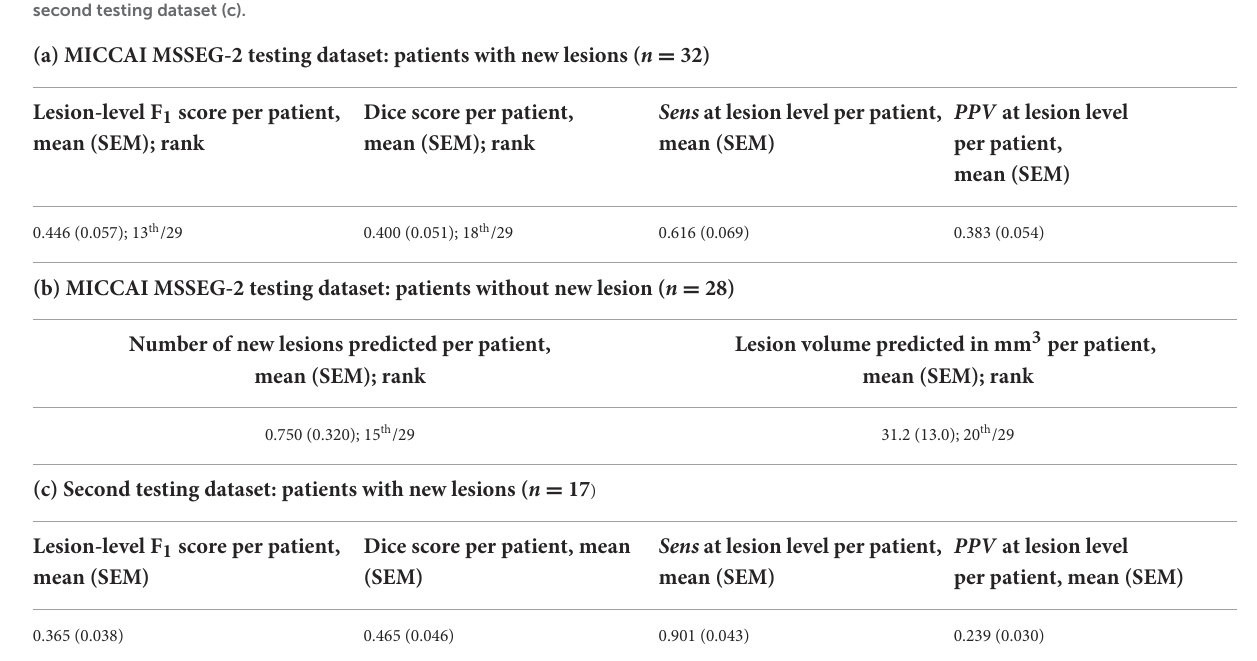
TABLE 1 Results on the testing set using MICCAI MSSEG-2 evaluation metrics, with the specific evaluation metrics from MICCAI MSSEG-2 testing dataset for the 32 patients with new lesions (a) as well as for the 28 patients without new lesions (b), and the 17 patients with new lesions from our second testing dataset